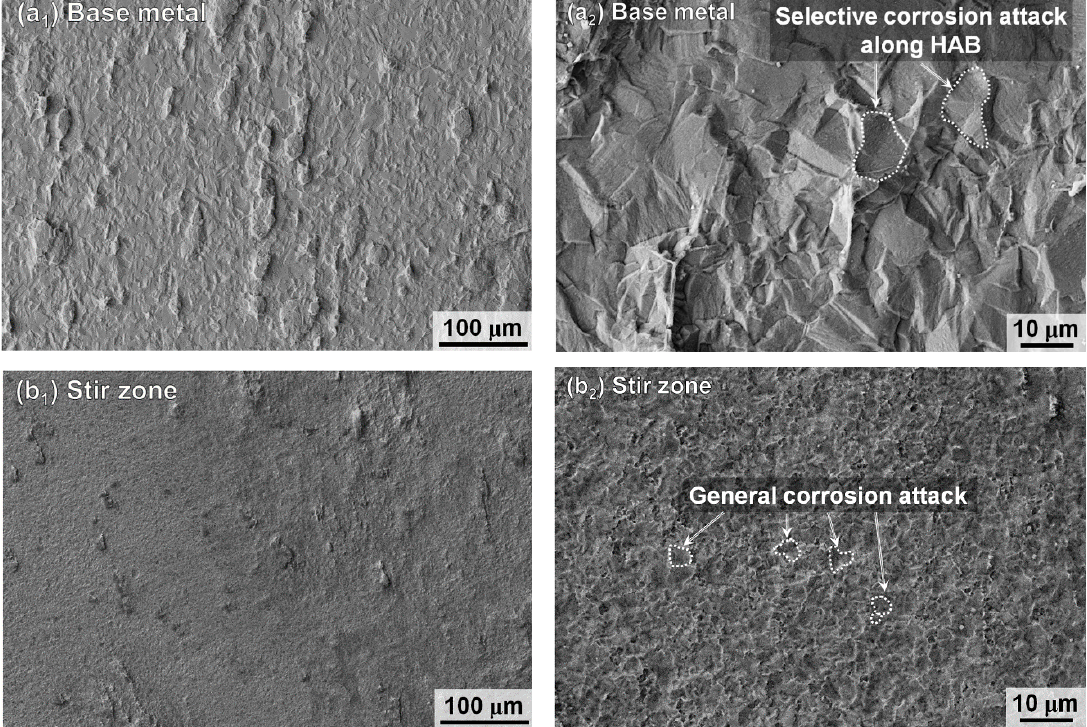
Figure 6. SEM images showing the corrosion morphology after the polarization test: ( a 1 , a 2 ) base metal and ( b 1 , b 2 ) stir zone specimens. The local areas of the base metal and stir zone specimens is magnified as shown in Figure 6 a 2 , b 2 , respectively.